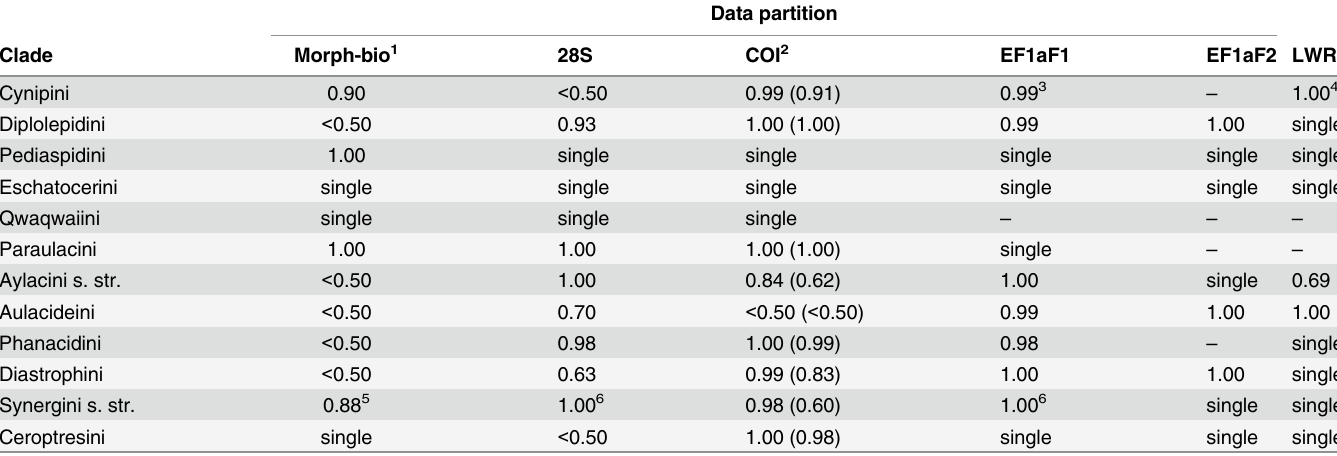
Table 2. Support for the cynipid tribes recognized in this paper across data